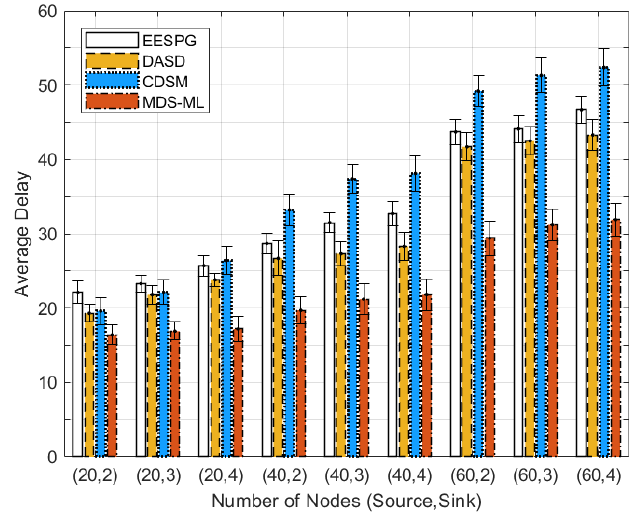
Figure 6. Average delay with different number of nodes.